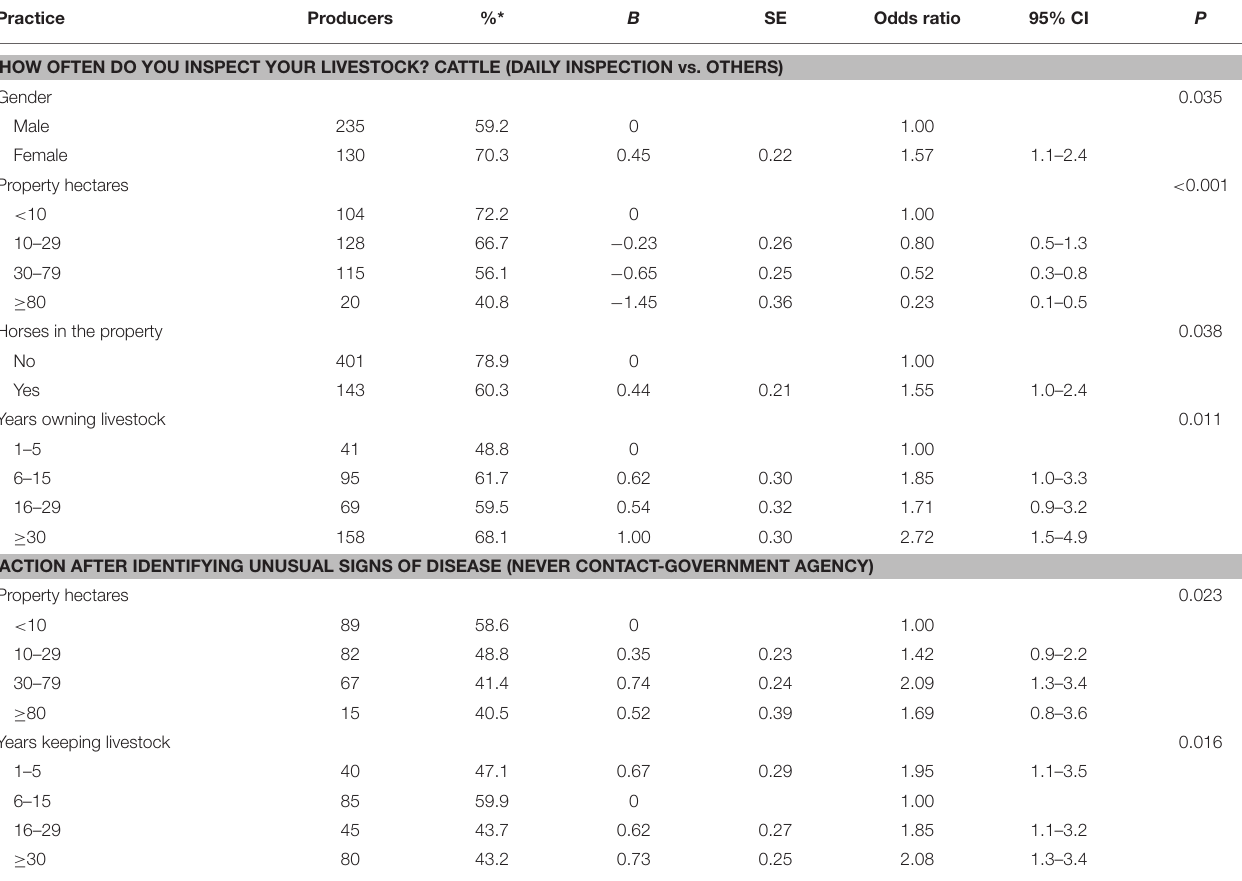
TABLE 4 | Results of a multivariable logistic regression analysis investigating animal health management practices (monitoring and attitudes toward disease as dependent variables) of 746 smallholders keeping cattle and sheep participating in a cross-sectional study in Australia in 2013–2015 (Only significant associations are shown). Practice Producers %* B SE Odds ratio 95% CI